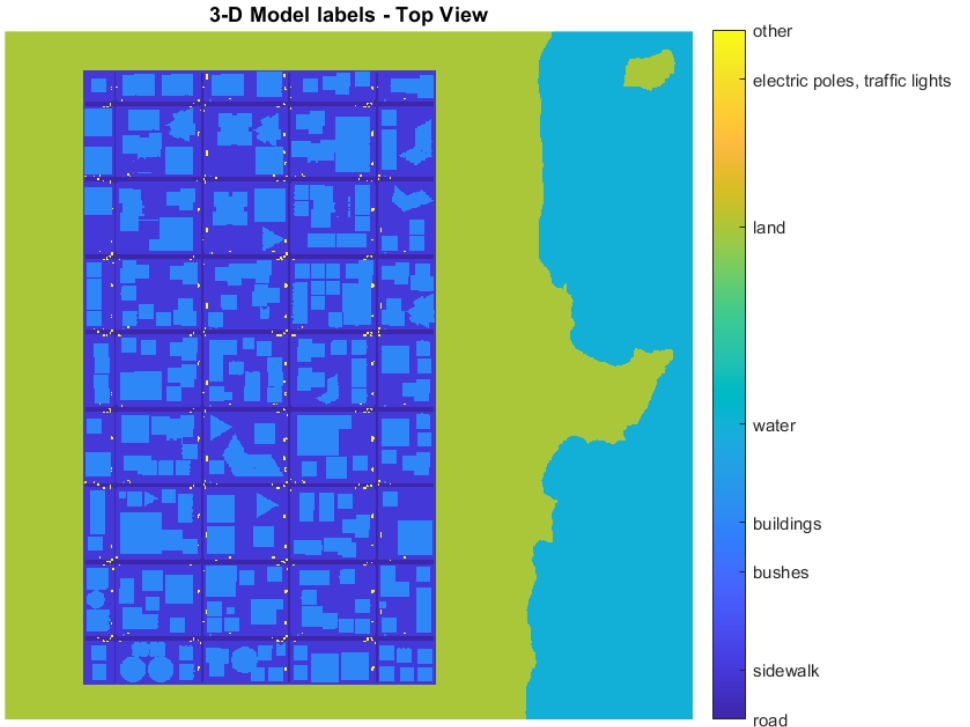
Figure 6. Top view of the digital surface model with chosen labels.